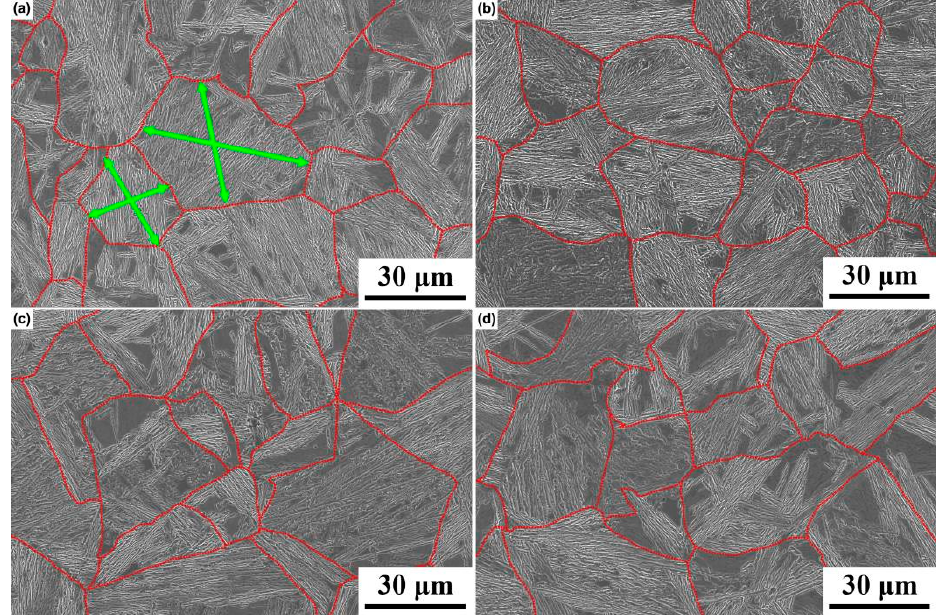
Figure 3. SEM images to measure the prior austenite grains of boro-austempered samples with varied boriding time: ( a ) 1 h; ( b ) 2 h; ( c ) 6 h; ( d ) 8 h. Table 2. Average PAGS and coating thickness of different boro-austempered samples.